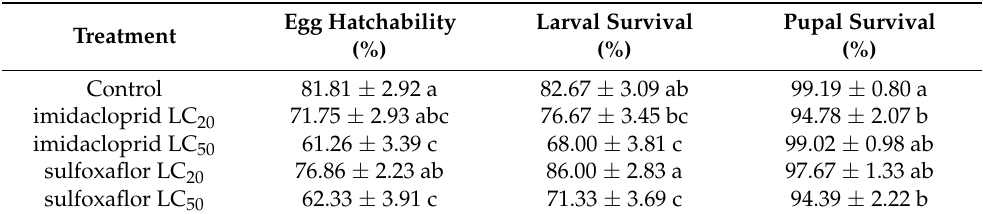
Table 4. Mean ( ± SE) values of egg-hatchability, larval and pupal survival of the offspring of Harmonia axyridis females exposed to imidacloprid and sulfoxaflor and their LC 50 and LC 20 estimated for the target pest, Aphis gossypii . Values followed by different letters, within the same column, indicate significant differences at p < 0.05 level.